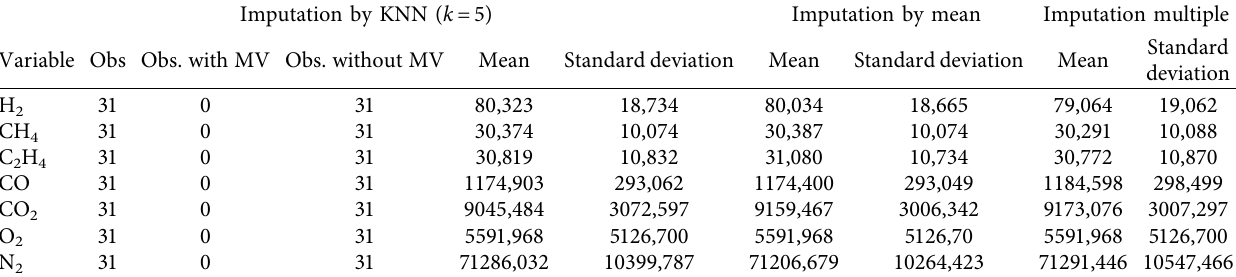
Table 4: Statistical data after imputations.